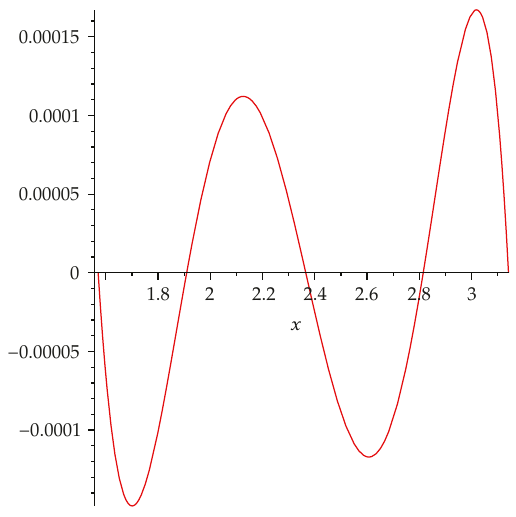
between sin x and p 4 (cid:2) x (cid:6) on (cid:4) π/ 2 ,π (cid:3) 4 (cid:2) x (cid:6)